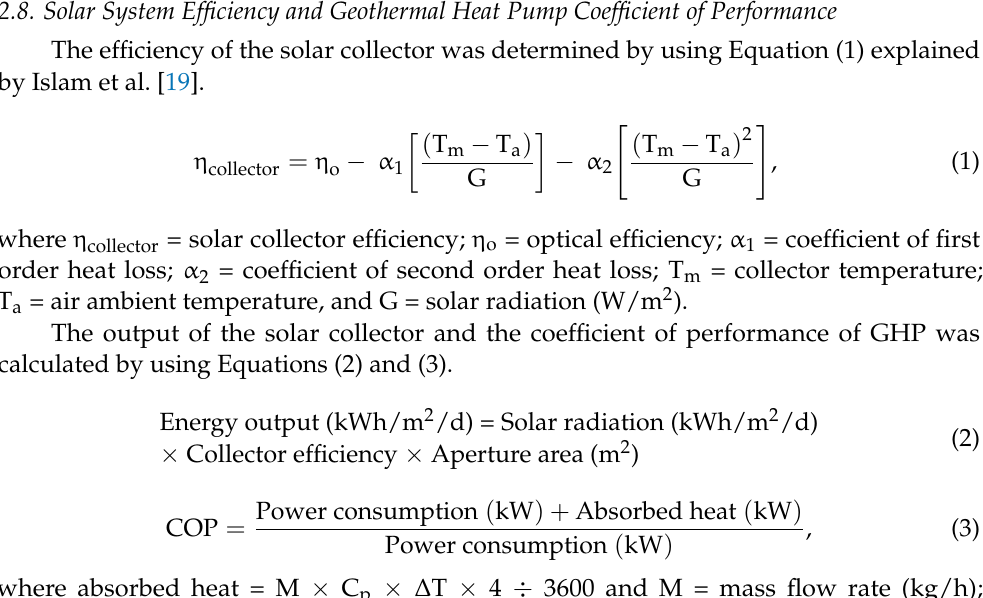
Figure 3. Combined geothermal and solar heating system flow diagram.